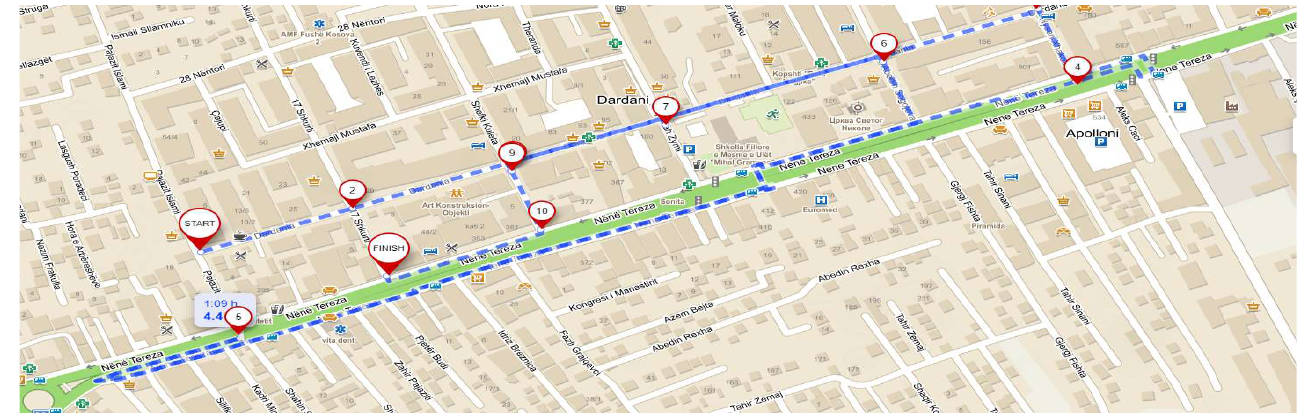
Figure 2. Road network maps where traffic counts were made.